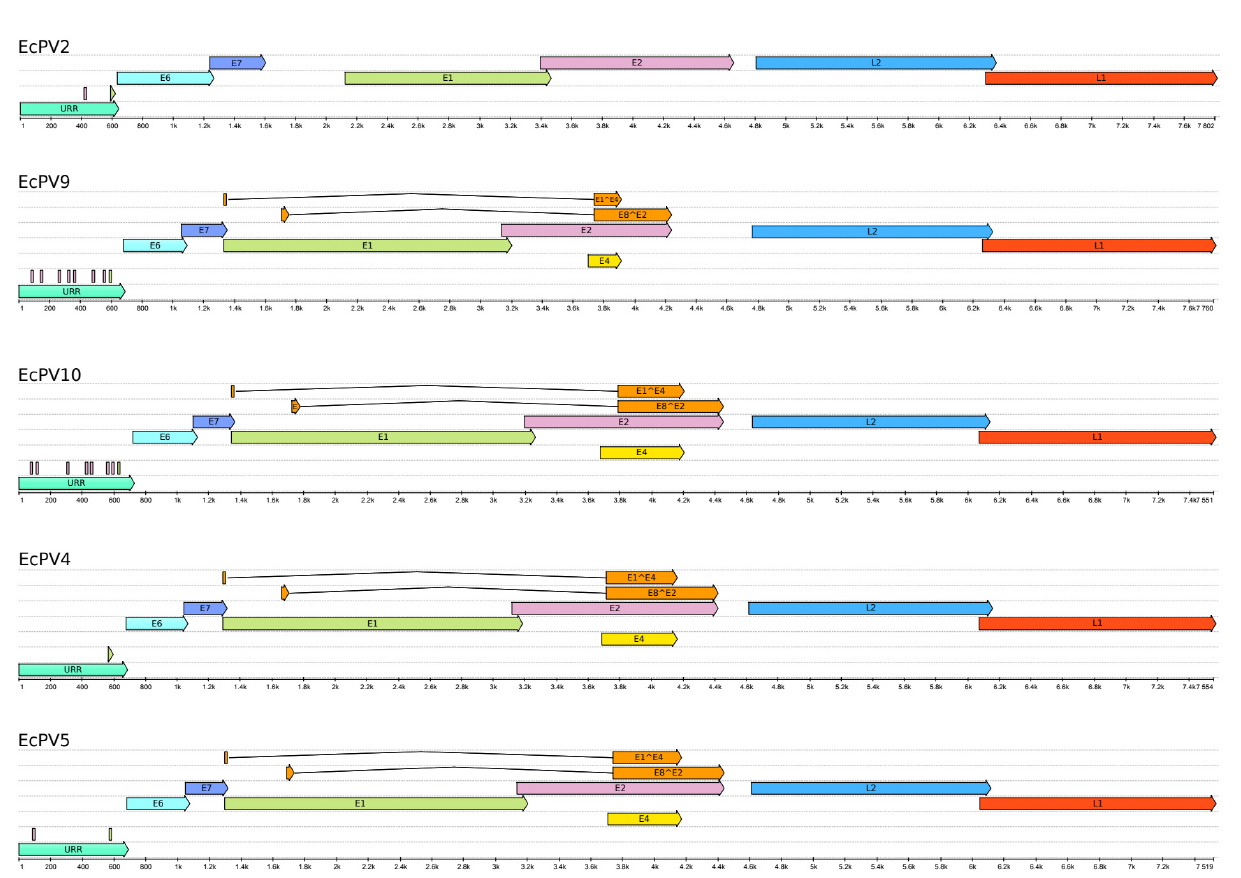
Figure 3. Schematic representation of the closest genomes related to EcPV10. Genomes were anno- tated with PuMA [29], and each ORFs or regulatory region is indicated with different colors. The picture was obtained with UGENE v36.0 www.ugene.net (last accessed on 2 January 2023) and ed- ited with Inkscape v0.92 (www.inkscape.org, last accessed on 2 January 2023).